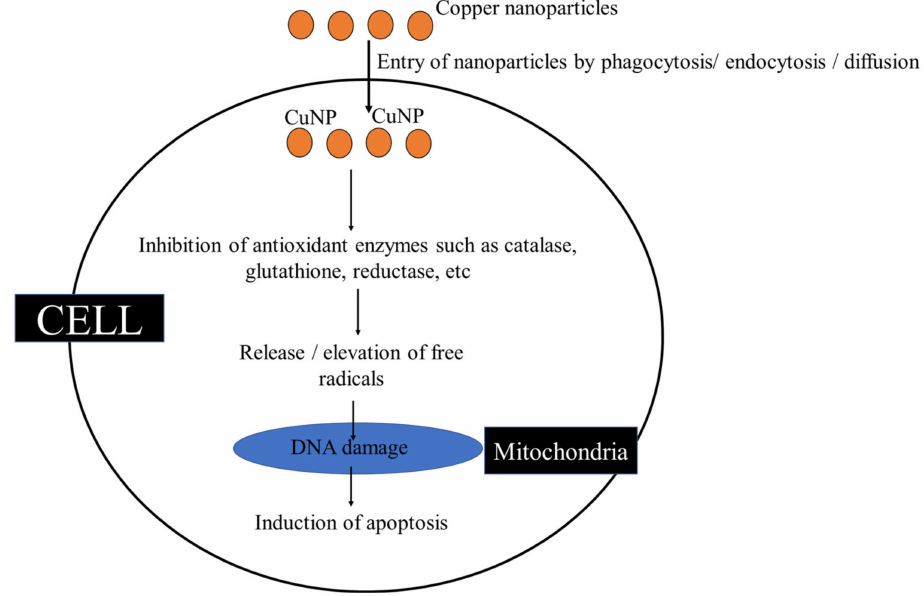
Figure 4. Oxidative damage caused by copper